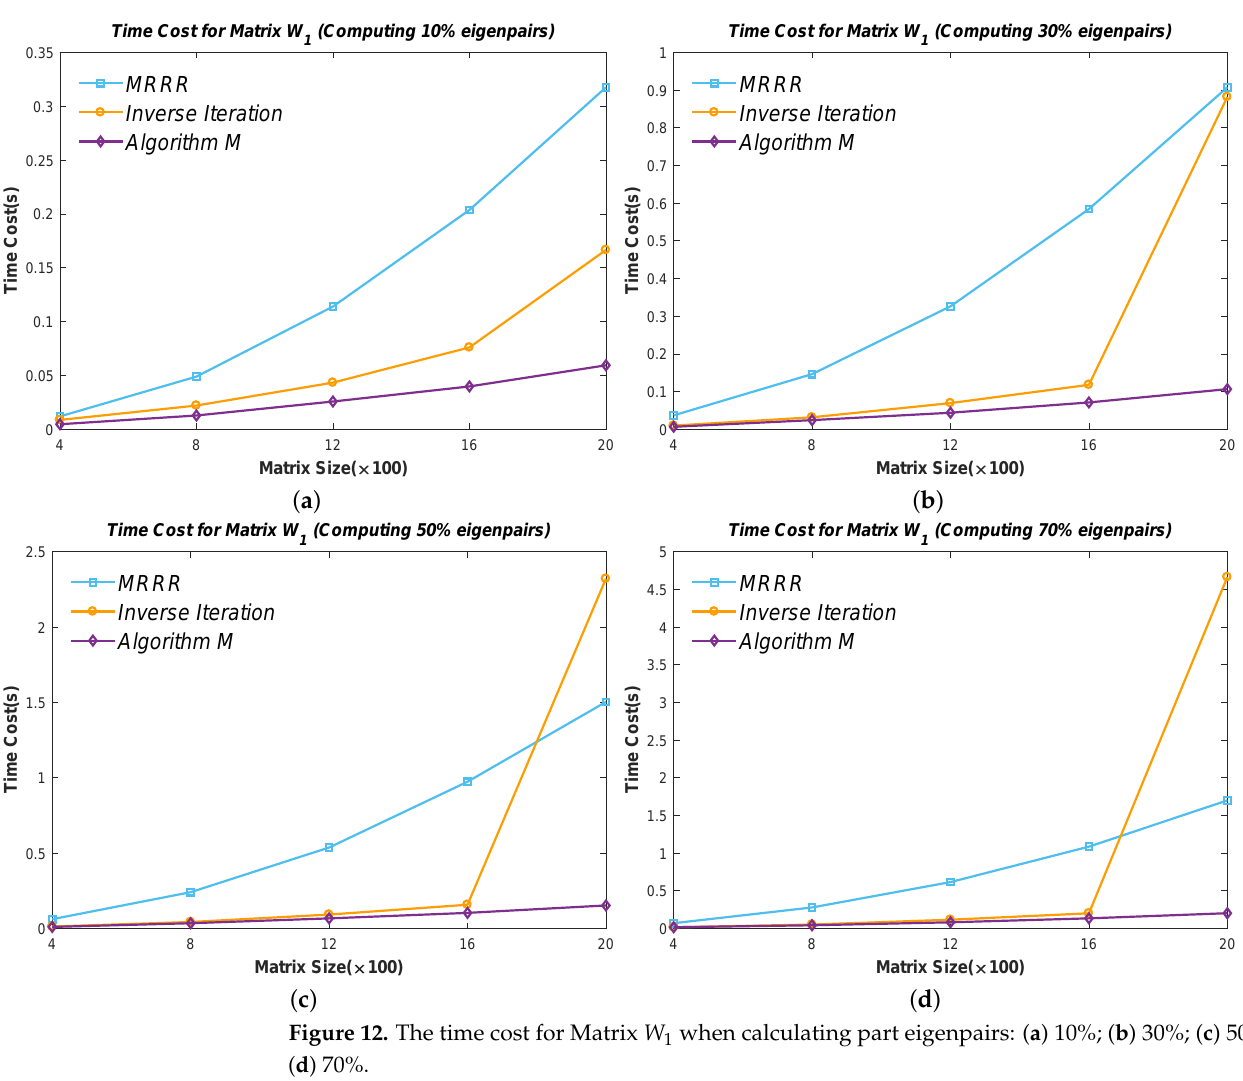
Figure 11. The time cost for Matrix Φ 2 when calculating part eigenpairs: ( a ) 10%; ( b ) 30%; ( c ) 50%; ( d ) 70%.